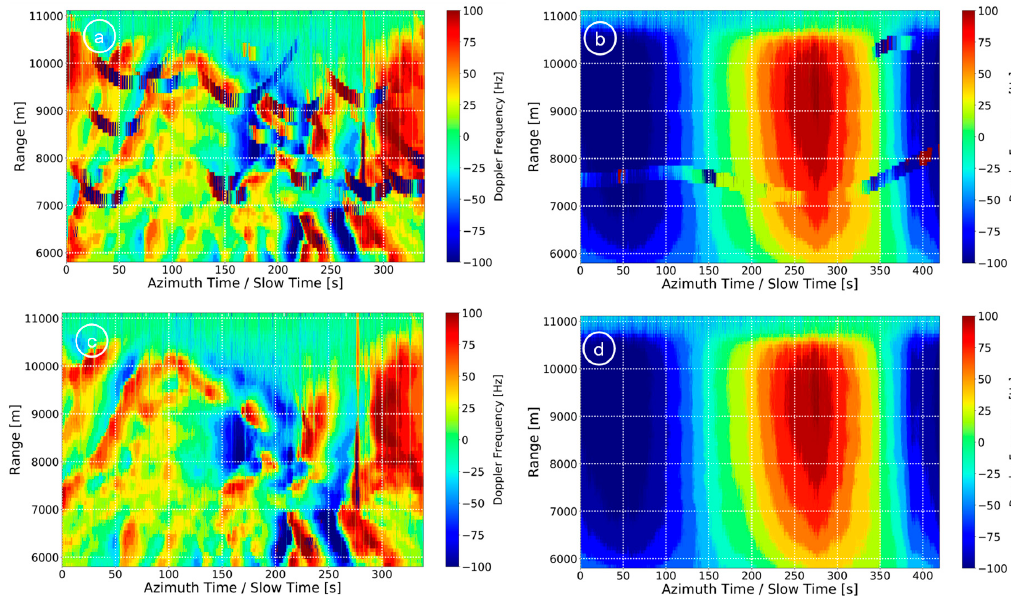
Figure 13. Doppler centroid map estimated from ( a ) linearly and ( b ) circularly acquired F-SAR L-band HH polarized RC data. The ship histories in both ( a ) and ( b ) can be clearly seen. ( c,d ) Doppler centroid maps re-estimated after cancelling the potential targets using the proposed pre-detection algorithm.